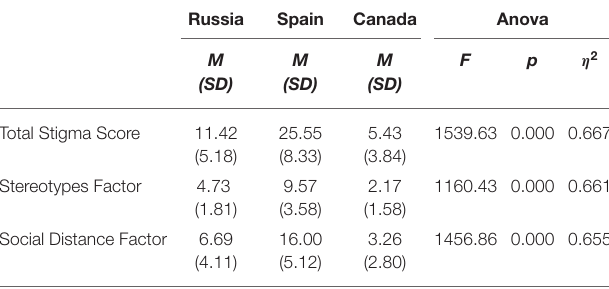
TABLE 1 | ANOVA for the average differences of stigma among Canadian, Russian and Spanish students.